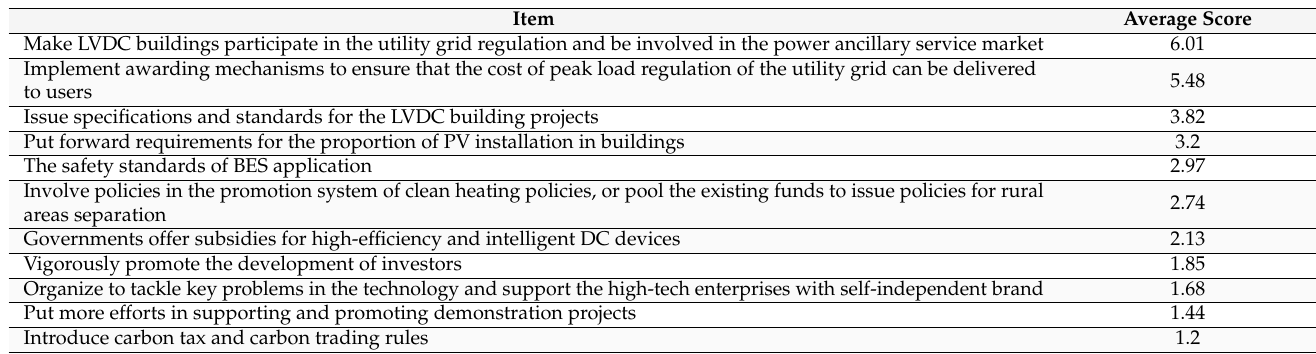
Table 5. Policy guiding which contributes to technology development.